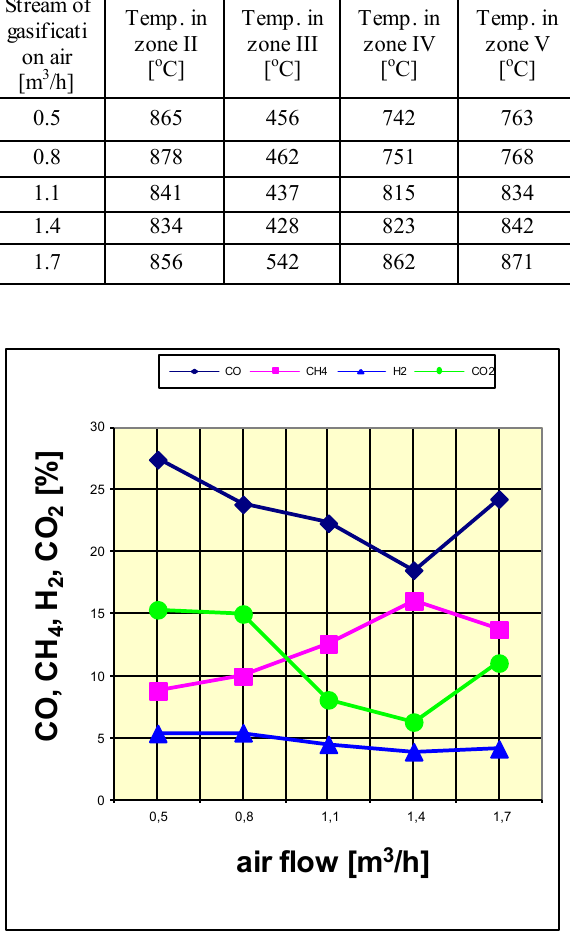
Fig. 3 . The effect of changes in the gasifier stream value on the value of gaseous